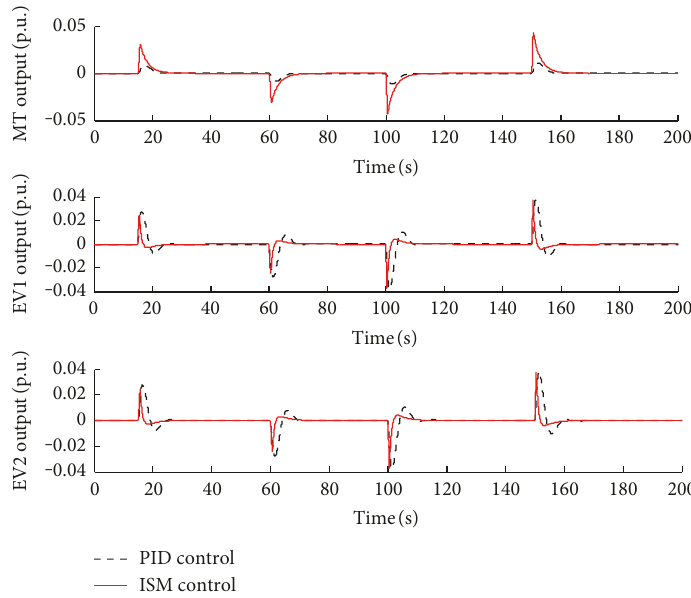
Figure 5: The output power of MT and EVs without power output